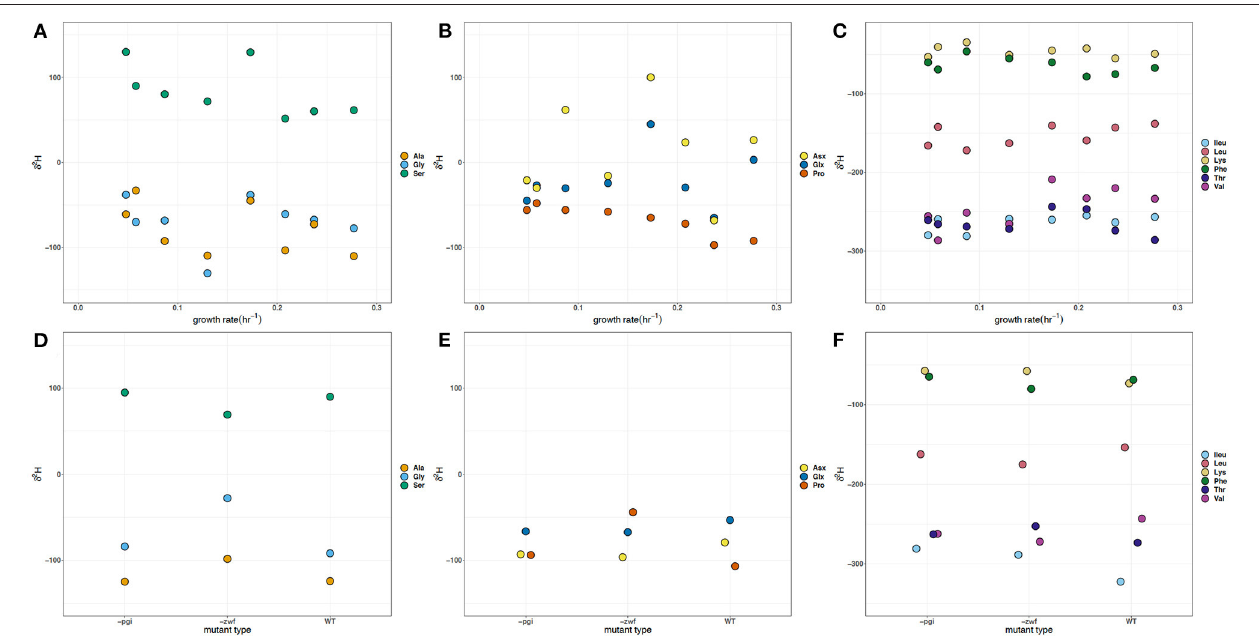
FIGURE 2 | δ 2 H of amino acids in Escherichia coli MG1655 chemostat cultures (A–C) and the WT strain along with mutant strains –pgi and –zwf in batch culture (D–F) . (A,D) The glycolytic amino acids: alanine (Ala), glycine (Gly), and serine (Ser). (B,E) The TCA cycle-dependent amino acids: aspartate + asparagine (Asx), glutamate + glutamine (Glx), and proline (Pro). (C,F) Branched amino acids: isoleucine (Ileu), leucine (Leu), lysine (Lys), threonine (Thr), and valine (Val) and aromatic amino acid: phenylalanine (Phe). The supplied glucose had a δ 2 H value of − 5.2 ‰ and media water δ 2 H values varied between − 65.9 and − 67.9 ‰ .